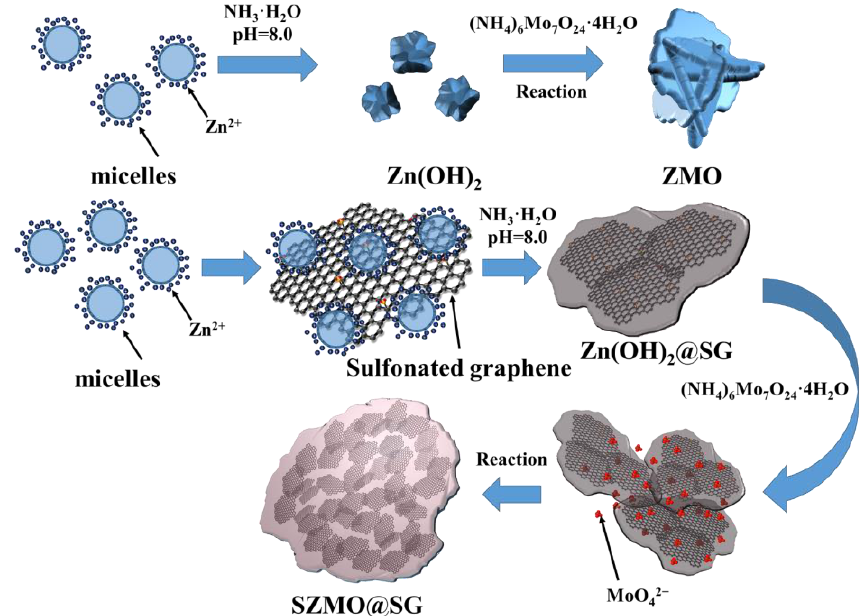
Figure 1. The schematic illustration of SZMO@SG synthesis.